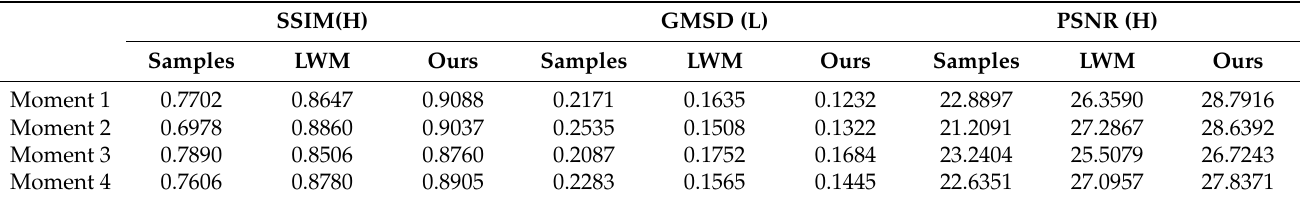
Figure 13. Recovery results of different methods. Left to right: the ground-truth image, the distorted structured light image, the sampled image at the corresponding moment, the results of the LWM method [51], and the results of our method. Up to down: recovery results of sampled images at different times using the above two methods. Table 1. Numerical comparison among sampled images, the LWM method, and our method.